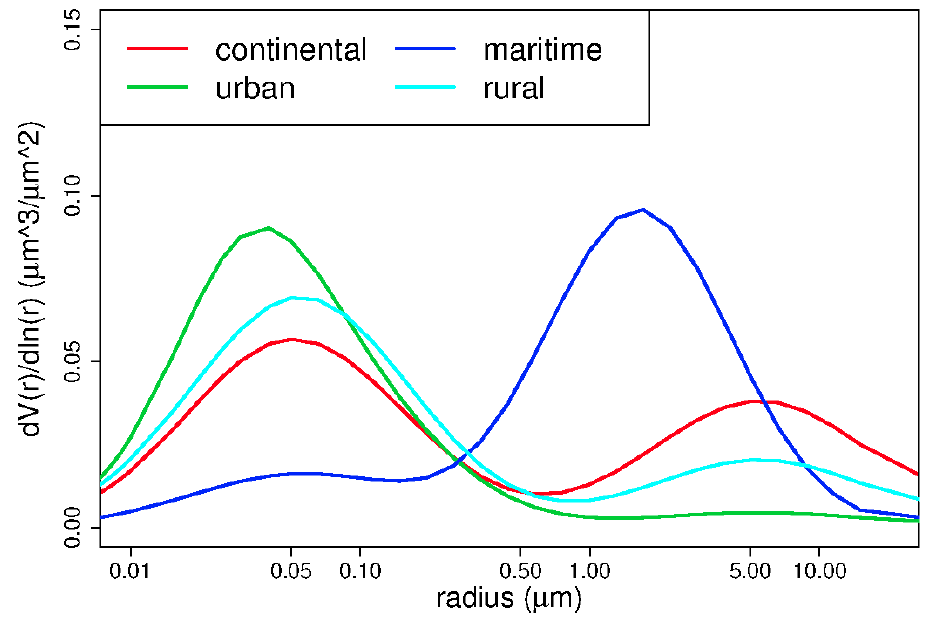
Figure 2. Size distribution of the four principal aerosol models: maritime (blue line), continental (red line), rural (cyan line), and urban (green line).